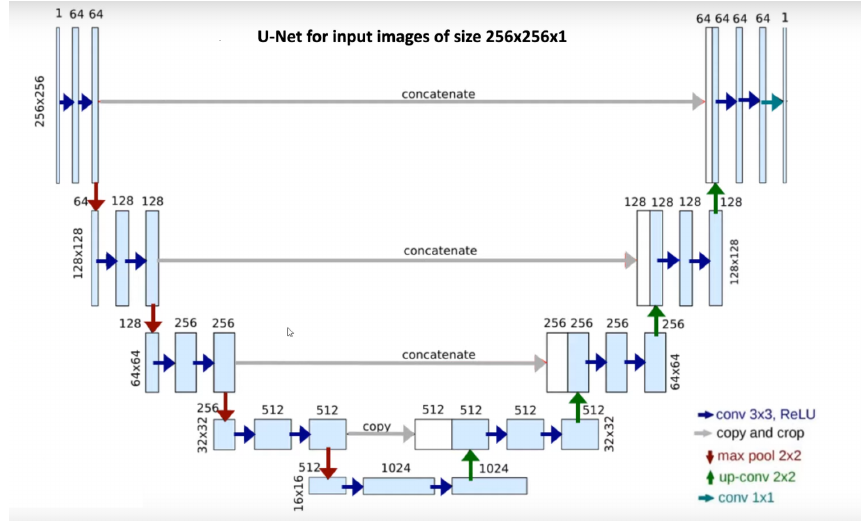
Figure 6. U-Net architecture used in this work [31]. Every blue box is a multichannel feature map, the number of the channel is denoted on the top of each box. The size information is provided at the lower left edge of each box. White boxes represent the feature maps that are copied through the skip connections, and the arrows represent the different